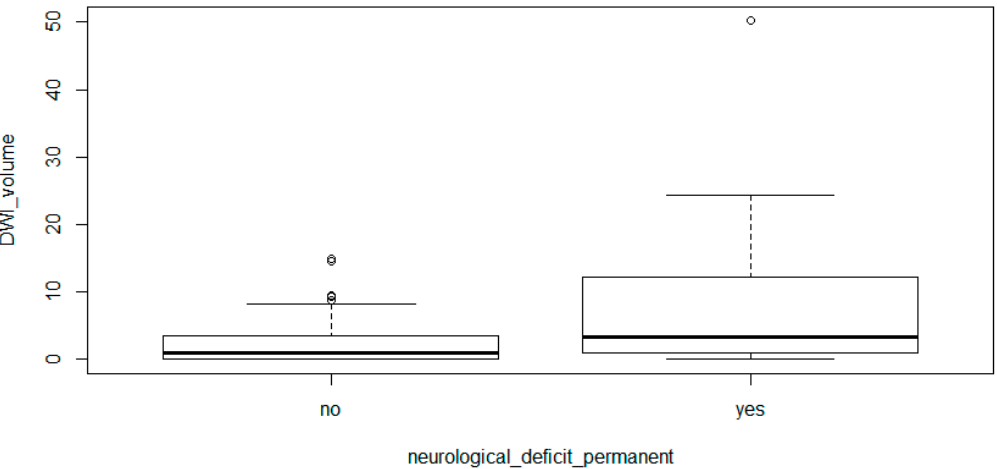
Figure 2. Comparison of patients with permanent (lasting more than 3 months) neurological deficits to patients with transient or no neurological deficits and their postoperative infarct volumes. Patients with new permanent deficits showed significantly higher infarct